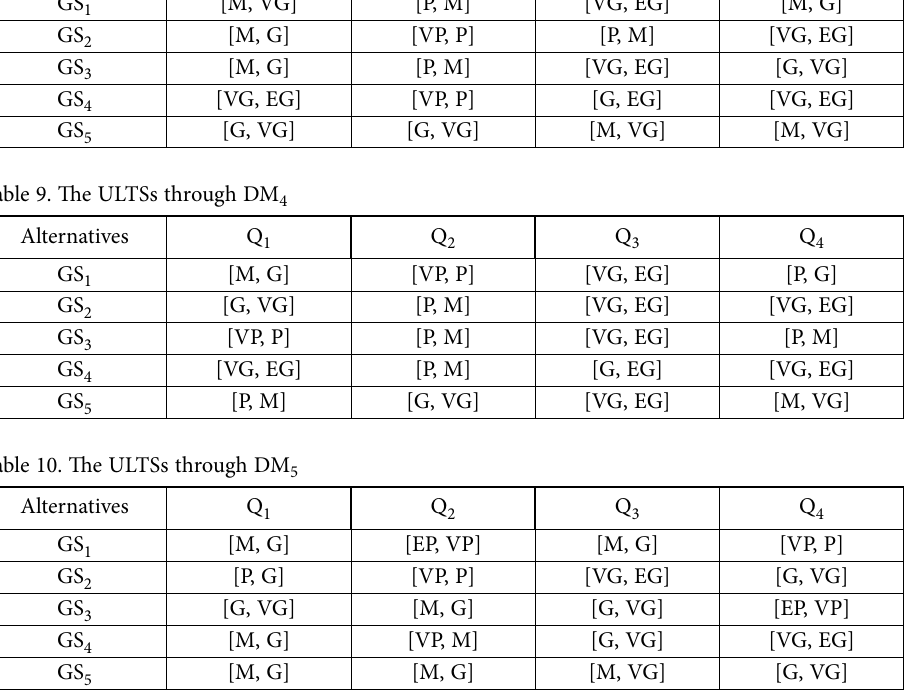
Table 8. The ULTSs through DM 3 Alternatives